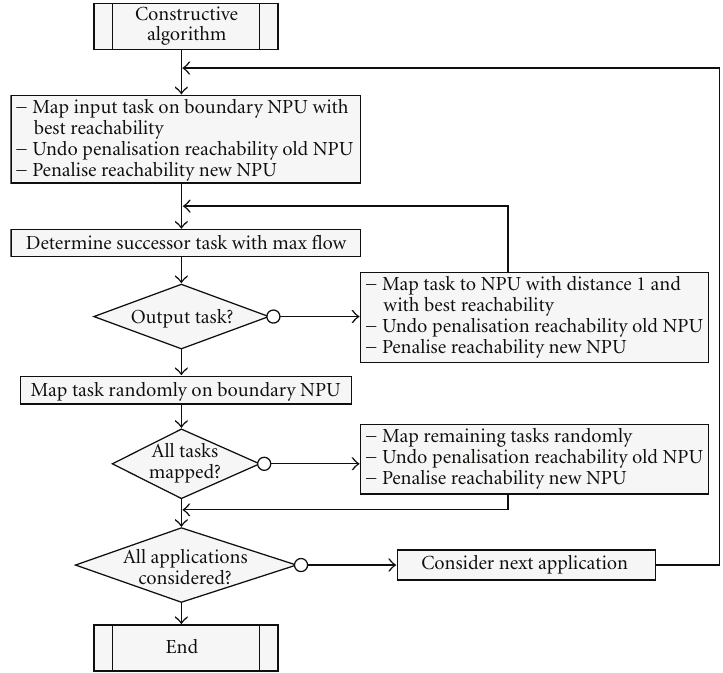
Figure 5: Program flow: constructive